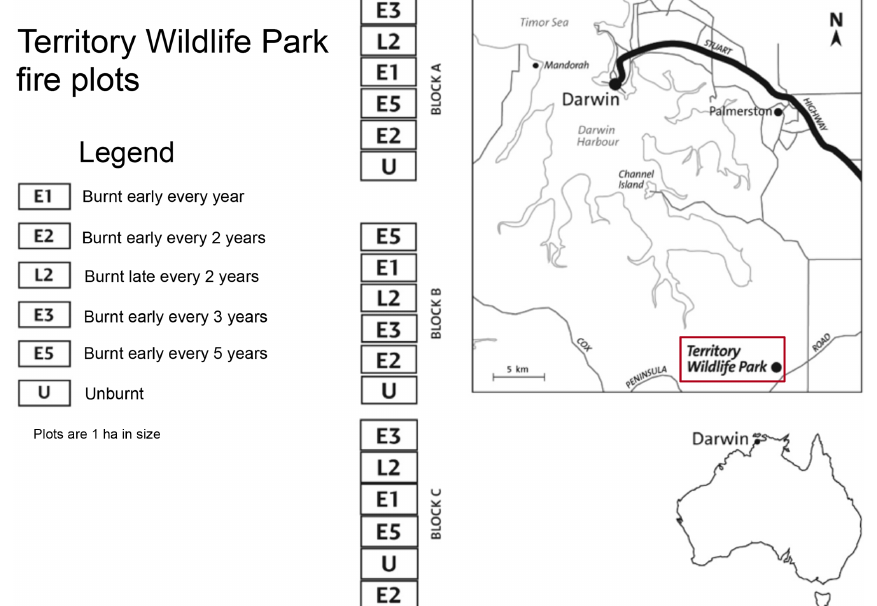
Figure 1. Location and experimental design of the Territory Wildlife Park fire manipulation experiment. Treatments were fist implemented in 2004. Soil depth and soil moisture increase from the northern to southern